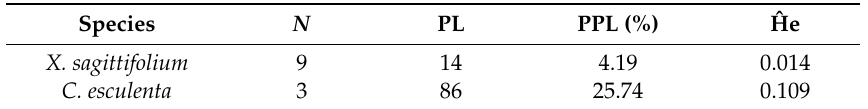
Table 3. Genetic diversity of specimens of X. sagittifolium and C. esculenta analyzed using ISSR molecular